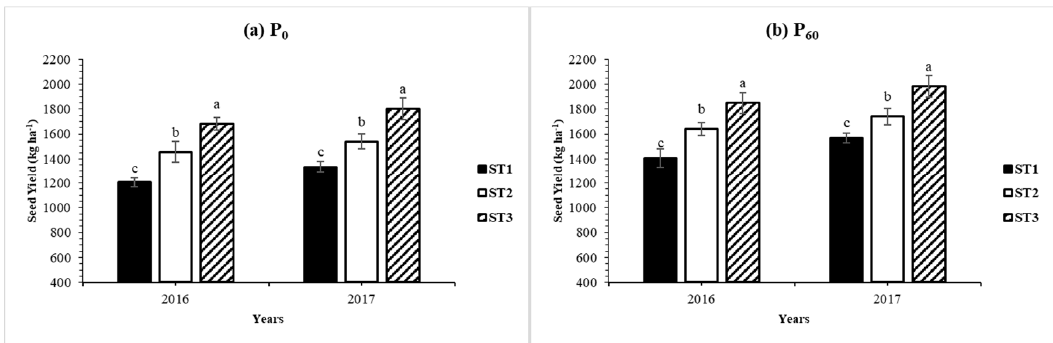
Figure. 3. Seed yield of relay intercrop soybean as affected by three different sowing times at two rates of phosphorus fertilizer (P 0 ; A and P 60 ; B ) during the cropping seasons of 2016 and 2017. ST 1 , ST 2 , and ST 3 represents the sowing times 15–20 May (90 days of co ‐ growth period in maize soybean relay intercropping system (MSICS)), 5–10 June (70 days of co ‐ growth period in maize soybean relay intercropping system (MSICS)), and 25–30 June, (50 days of co ‐ growth period in maize soybean relay intercropping system (MSICS)), respectively. The P 0 and P 60 refer to 0 and 60 kg phosphorus ha − 1 , respectively. Means are averaged over three replicates. Bars indicate ± standard errors, ( n = 3). Between bars in groups, different lowercase letters indicate a significant difference ( p < 0.05) between sowing times in each of the two years and at each of the phosphorus fertilization levels.